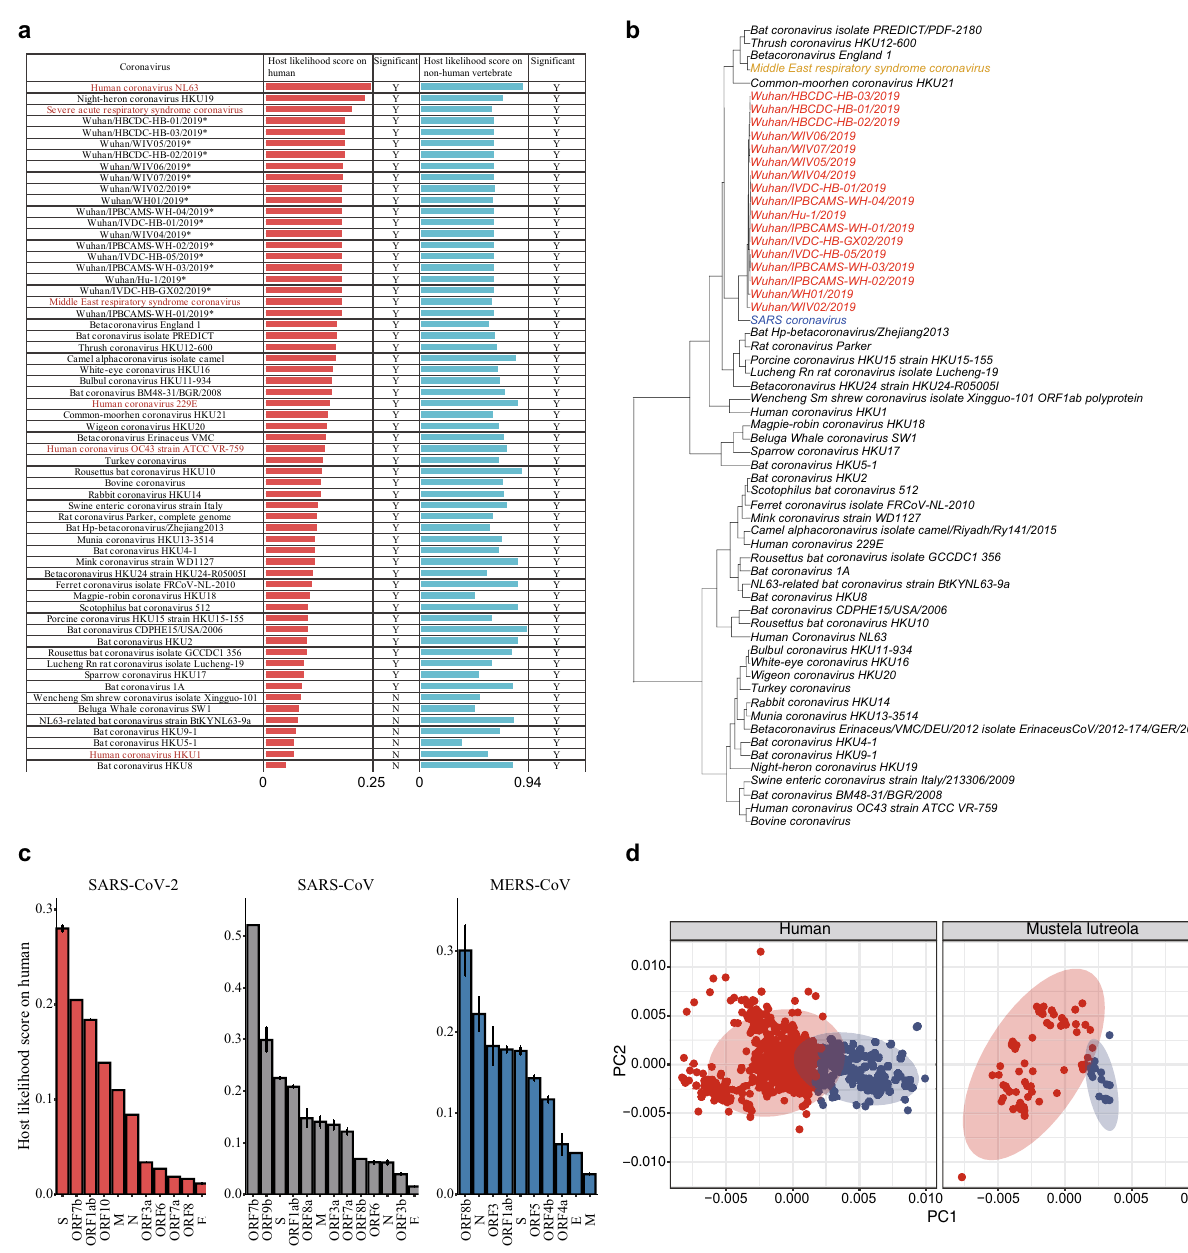
Figure 3. Evaluation of host likelihood scores of SARS-CoV-2. The contribution of each gene in the prediction and the visualization of host likelihood score profiles of SARS-CoV-2 isolates sampled in Netherlands. ( a ) Host likelihood scores of 17 earliest detected SARS-CoV-2 isolates and other coronaviruses on humans and non-human vertebrates. SARS-CoV-2 showed high host likelihood scores on both humans and non-human vertebrates with p values less than 0.05. In addition, SARS-CoV-2 was predicted lower score than SARS-CoV and comparable score to MERS-CoV on human. As for host likelihood scores on non-human vertebrates, SARS- CoV-2, SARS-CoV and MERS-CoV were close to each other. Host likelihood scores have p values less than 0.05 are marked ‘Y (yes)’ (red: human-infecting coronaviruses; *: the 17 earliest collected SARS-CoV-2 isolates). ( b ) Hierarchical clustering of early-stage SARS-CoV-2 and other coronaviruses using five-dimensional host likelihood score profiles given by DeepHoF. The profile of SARS- CoV-2 was close to that of SARS-CoV and MERS-CoV (red: SARS-CoV-2; blue: SARS-CoV; yellow: MERS-CoV). ( c ) Contributions of the protein coding genes on determining the host likelihood scores of SARS-CoV-2, SARS-CoV and MERS-CoV on human. The structural genes, ORF1ab and group-specific genes contributed differently in the three coronaviruses (two-sided unpaired Welch Two Sample t test, p value < 0.05, see in Supplementary Fig. S3). S, ORF7b and ORF1ab were the most pivotal in SARS-CoV-2. ORF7b, ORF9b and S were the most considerable in SARS-CoV. ORF8b, N and ORF3 contributed the most in MERS-CoV (S: spike glycoprotein coding gene; M: membrane/matrix glycoprotein coding gene; N: nucleocapsid phosphoprotein coding gene; E: envelope coding gene). ( d ) Principal component analysis (PCA) of host likelihood score profiles of SARS-CoV-2 detected on humans and minks in the Netherlands. All the SARS-COV-2 isolates in the Netherlands were divided into a large cluster (red) and a small cluster (blue) by the pam function of the R package cluster. The host likelihood score profiles of human-derived (left) and mink-derived (right) SARS- CoV-2 isolates in the Netherlands were distributed in a consistent mode, both containing the majority from large cluster (red) and the minority from the small cluster